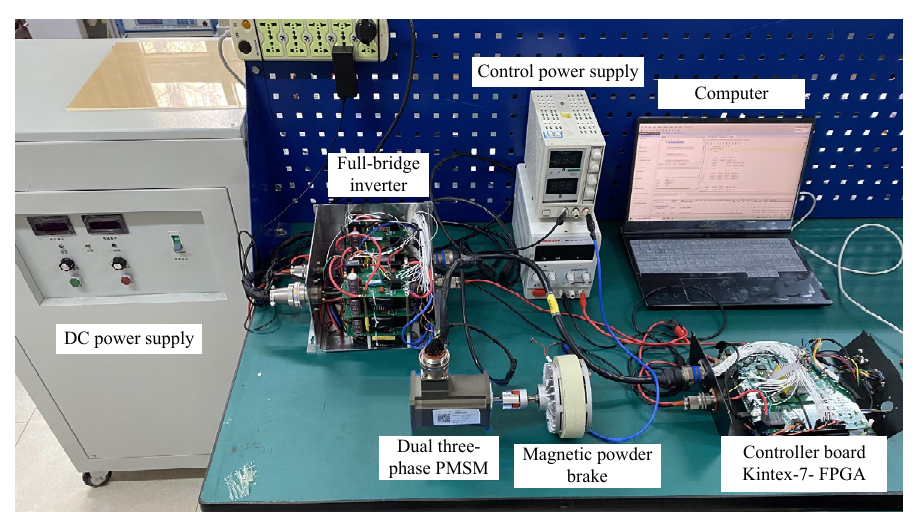
Figure 14. Experimental platform.